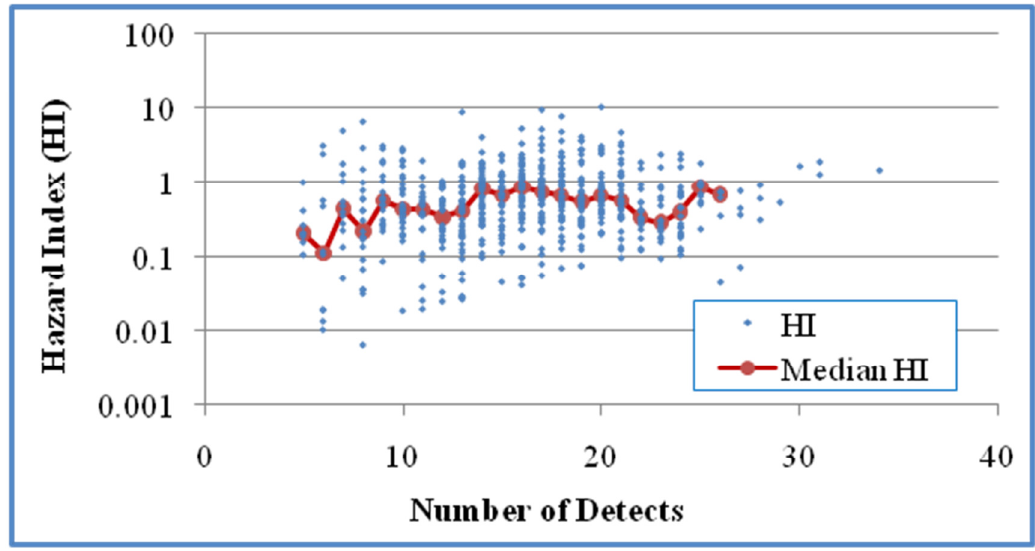
Figure 3. The relationship between HI and the number of detects in the samples for Case 1 (618 mixtures). A positive correlation was shown based on all mixtures (Kendall’s τ = 0.085 and p < 0.01) but not median HI of grouped mixtures for groups with at least five values (τ = 0.0913 and p > 0.05).